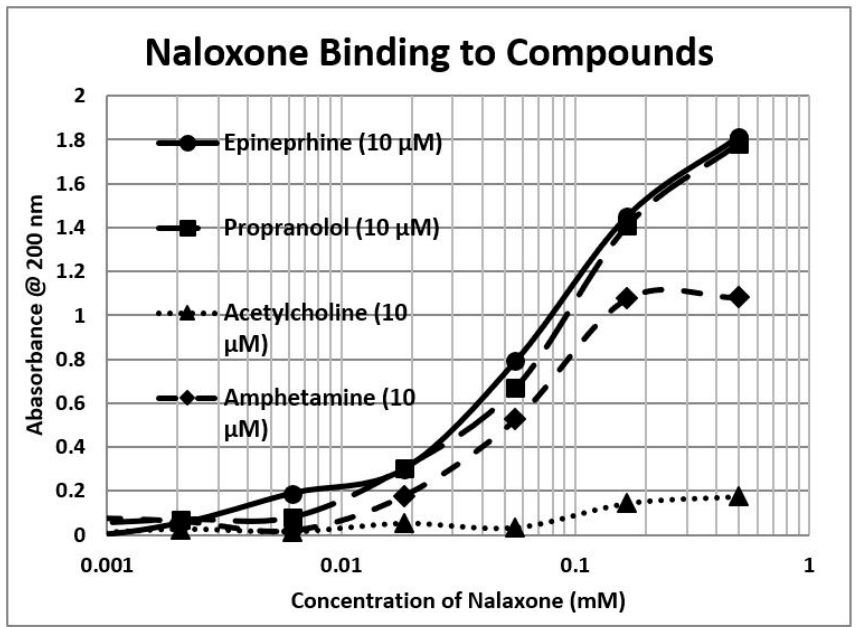
Figure 3. Ultraviolet spectroscopy study of naloxone binding to various adrenergic compounds. See Table 1 and Figures 1 and 2 for additional data.